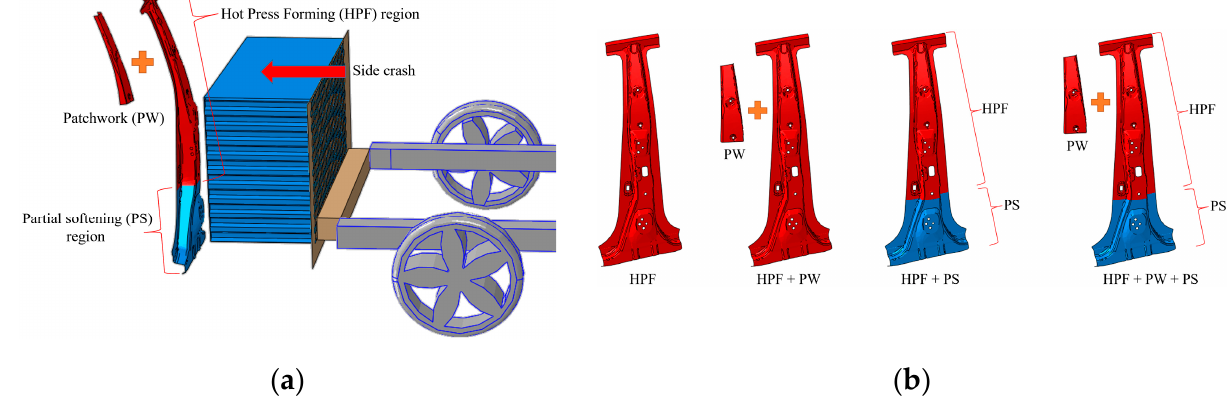
Figure 1. ( a ) Function of the center pillar during a side crash. ( b ) Four kinds center pillars